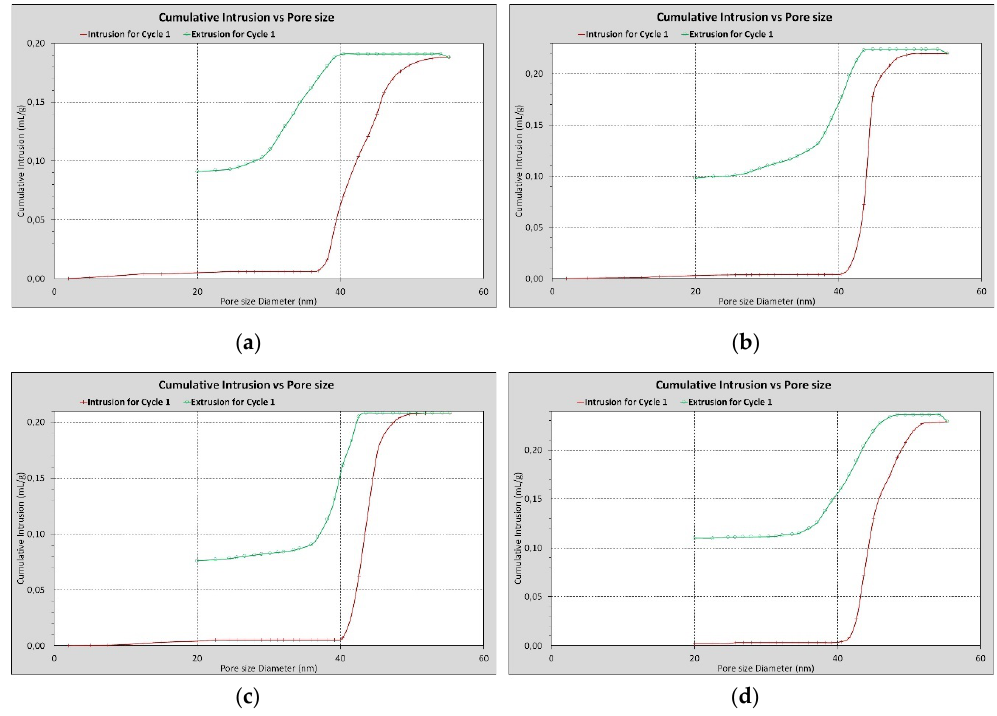
Figure 11. ( a ). Pore size distribution of slurry X. ( b ). Pore size distribution of slurry XI. ( c ). Pore size distribution of slurry XII. ( d ). Pore size distribution of slurry XIII.